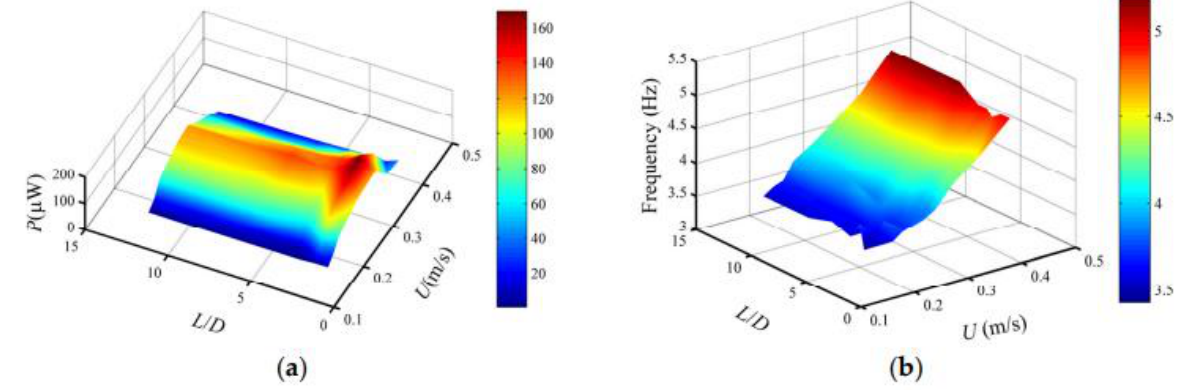
Figure 12. Changes in upstream as a result of water velocity, harvester output power, and vortex- formation frequency and separation ratio: ( a ) water velocity and spatial ratio influence output power; ( b ) upstream harvester vortex shedding frequency as a result of water velocity and separation ratio [199].